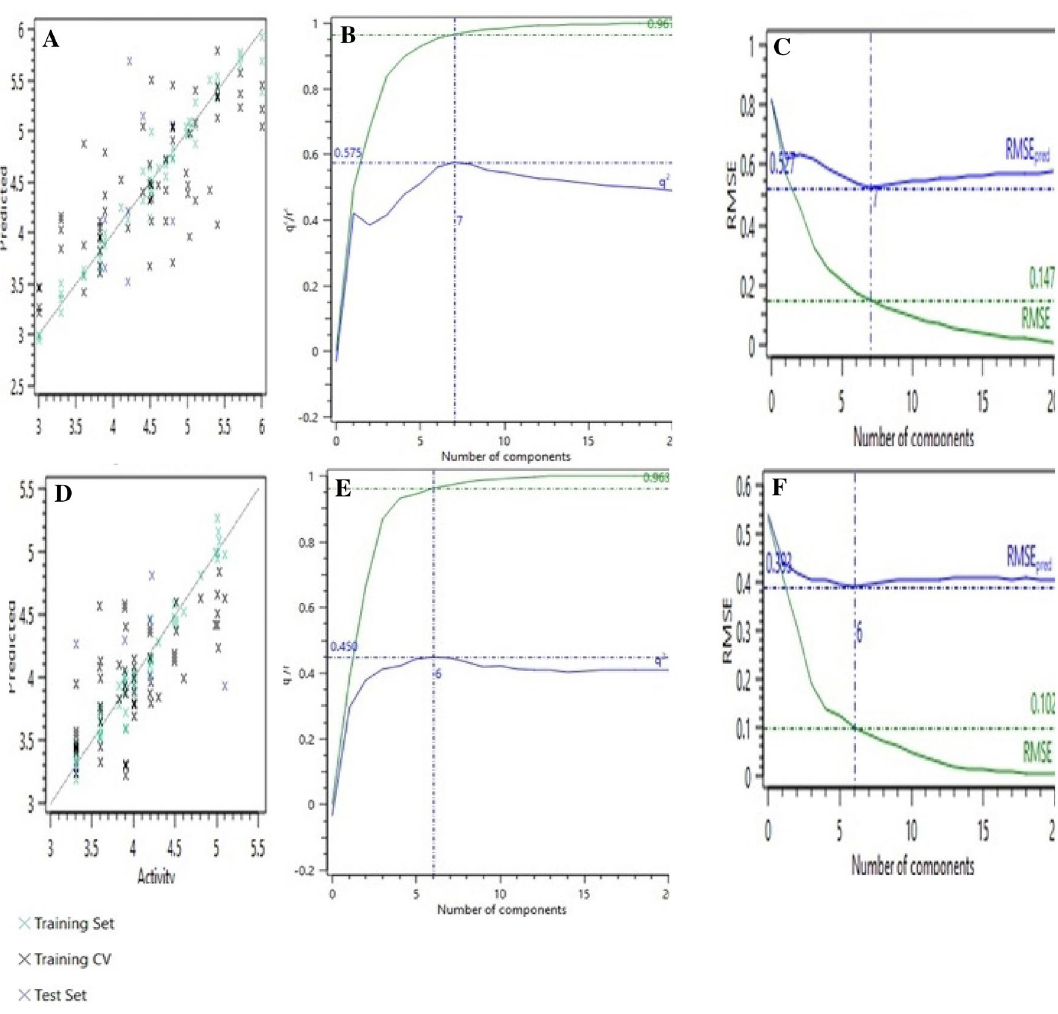
Figure 5. The left column shows an activity interactive graph plot among experimental and predicted activity. The Middle column presented 3D-qsar model performance graph plot of r 2 and q 2 and the number of components. The right column shows the RMSE. ( A – F ) Belongs to S. aureus , and E. coli ,